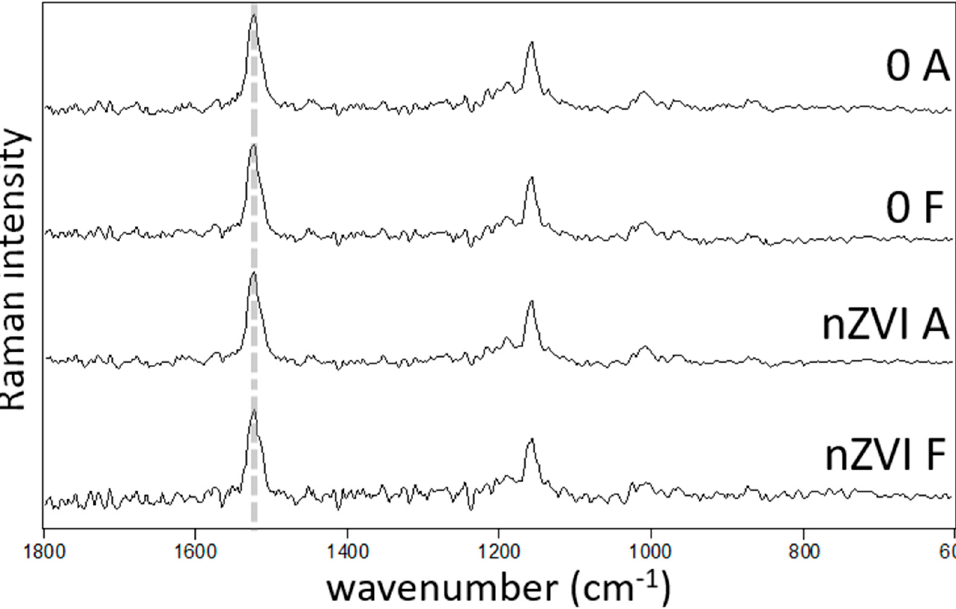
Figure 4. Raman spectra of A. capillaris (A) and F. rubra (F) untreated (0) and treated with 100 mg L − 1 nZVI, presented as an average from three measurements at distinct zones of the leaf. The spectral features correspond to carotenoids; the v1(C = C) band position (dashed line), which may reflect changes in the carotenoid structure remains the same (1523 cm − 1 ) among the measurements.